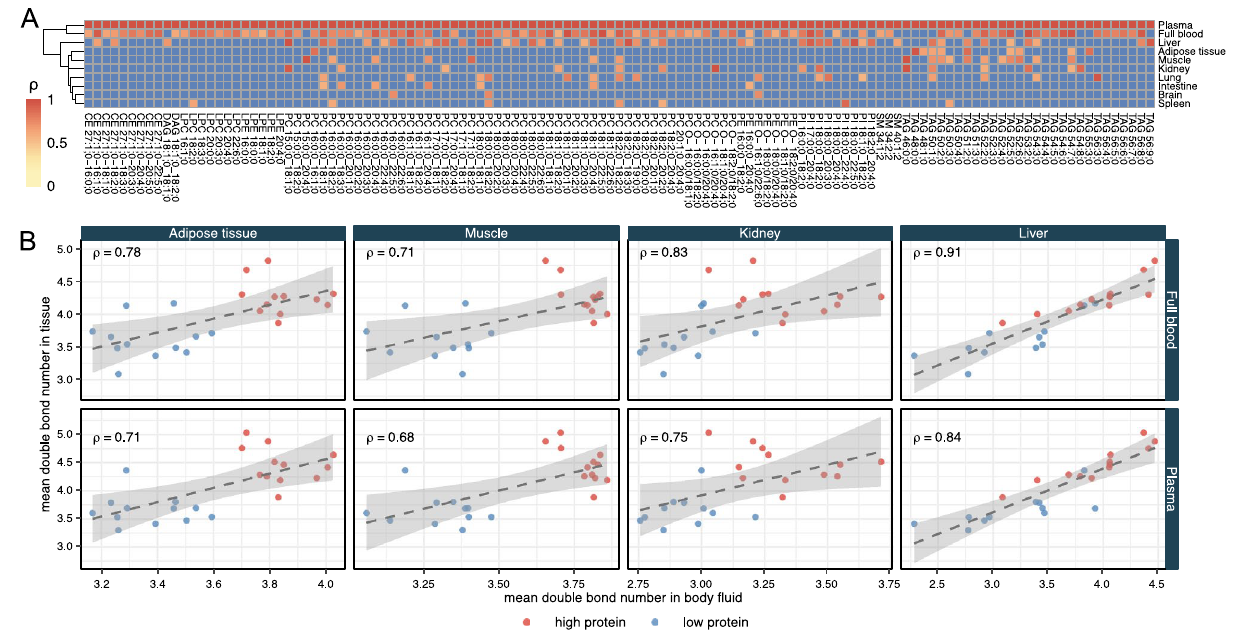
Figure 6. Correlations of organ lipidomes with blood lipidomes. ( A ) Hierarchical clustering based on correlation coefficients for diet effects on individual lipids in different organs with lipids in blood plasma as reference point. Colour scale indicates correlation coefficient ρ . Non-significant positive correlations and negative correlations are shown in blue. ( B ) Scatter plots showing correlations for TAG lipidomic features in organs with counterparts in blood plasma and full blood. Dashed lines show a linear regression of the data (with grey areas indicating the 95% confidence interval). In both panels only significant ( p < 0.05 ) positive correlations are shown and correlations were adjusted for sex and